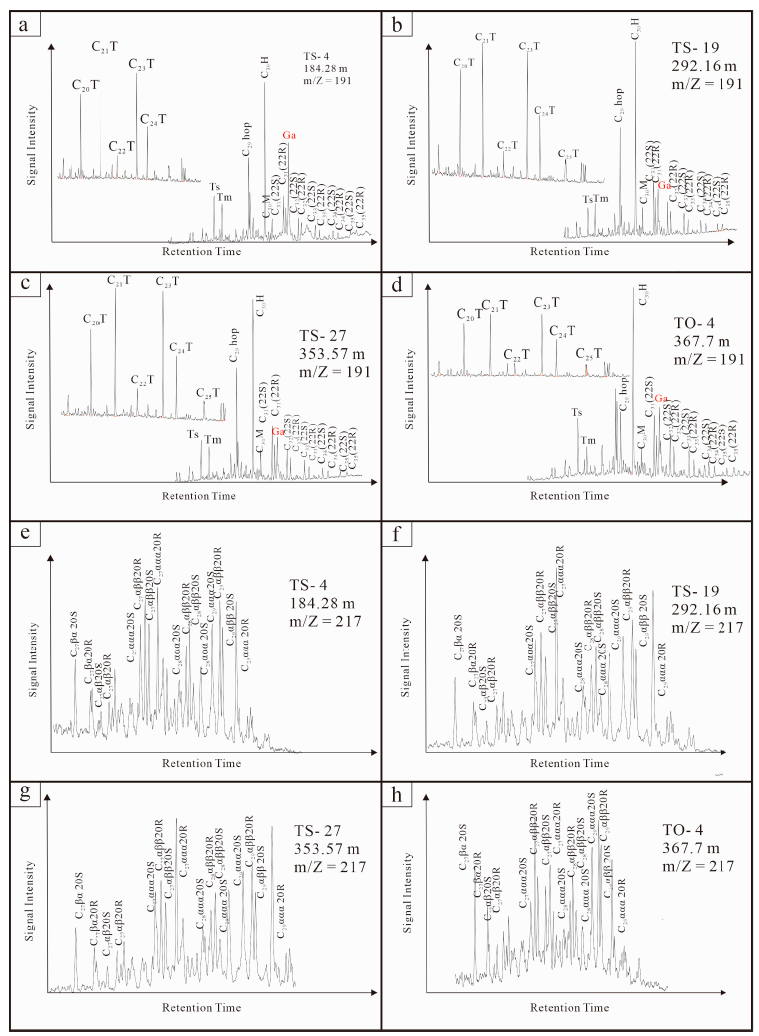
Figure 8. The m/z 191 ( a – d ) and m/z 217 ( e – h ) mass chromatogram of saturated hydrocarbons of the Hengtongshan Formation samples in the Tonghua Basin.